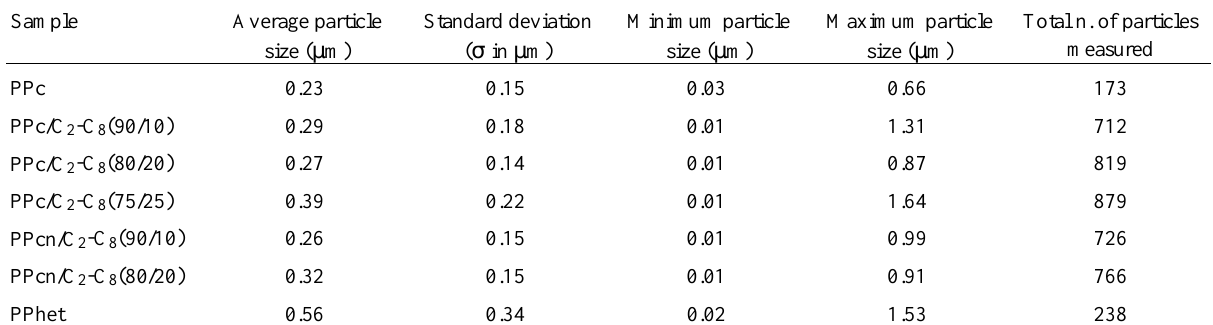
Table 3. Quantitative morphological analysis of PPc, PPcn and their blends with C 2 -C 8 . Sample